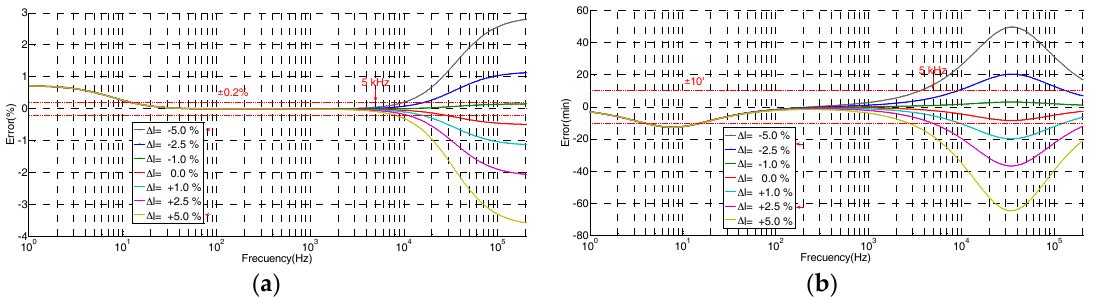
Figure 4. Errors due to difference of length of coaxial cable C c regarding to the theoretical value